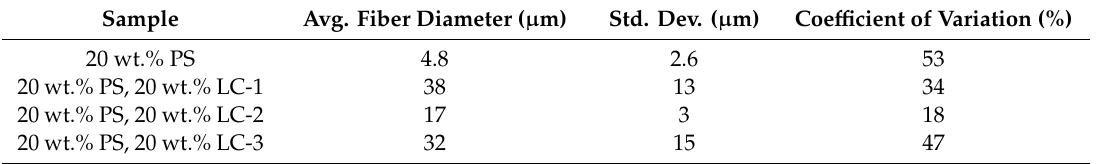
Table 2. Average fiber sizes for 20 wt.% PS, 20 wt.% LC for the three LC formulations.